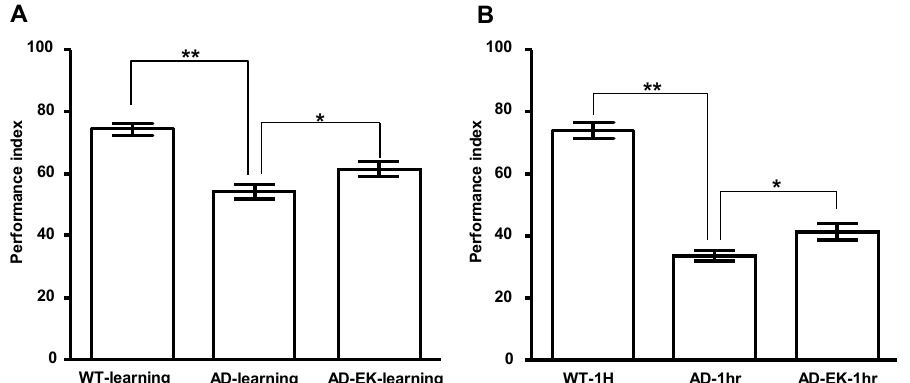
Figure 2. Ergosta-7,9(11),22-trien-3 β -ol improved ( A ) the learning ability and ( B ) one-hour memory of AD Drosophila. Error bar stands for standard error of mean, while * or ** denote p < 0.05 or 0.01 in Student’s t -test, respectively. WT denotes wildtype control. AD denotes Alzheimer’s model. AD-EK denotes the Alzheimer’s model treated with ergosta-7,9(11),22-trien-3 β -ol (EK100).